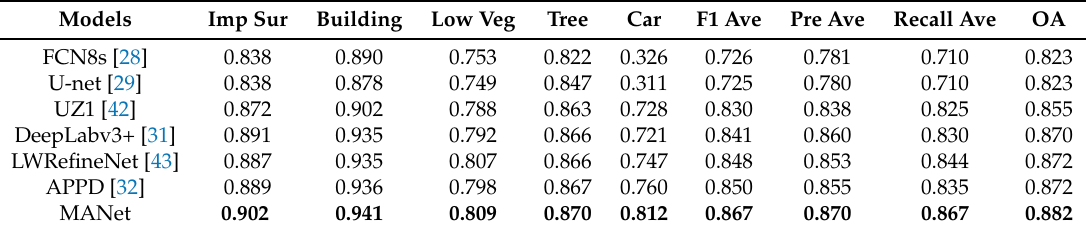
Table 3. The F1 for each category and the average of four metrics of the seven models on the Vaihingen